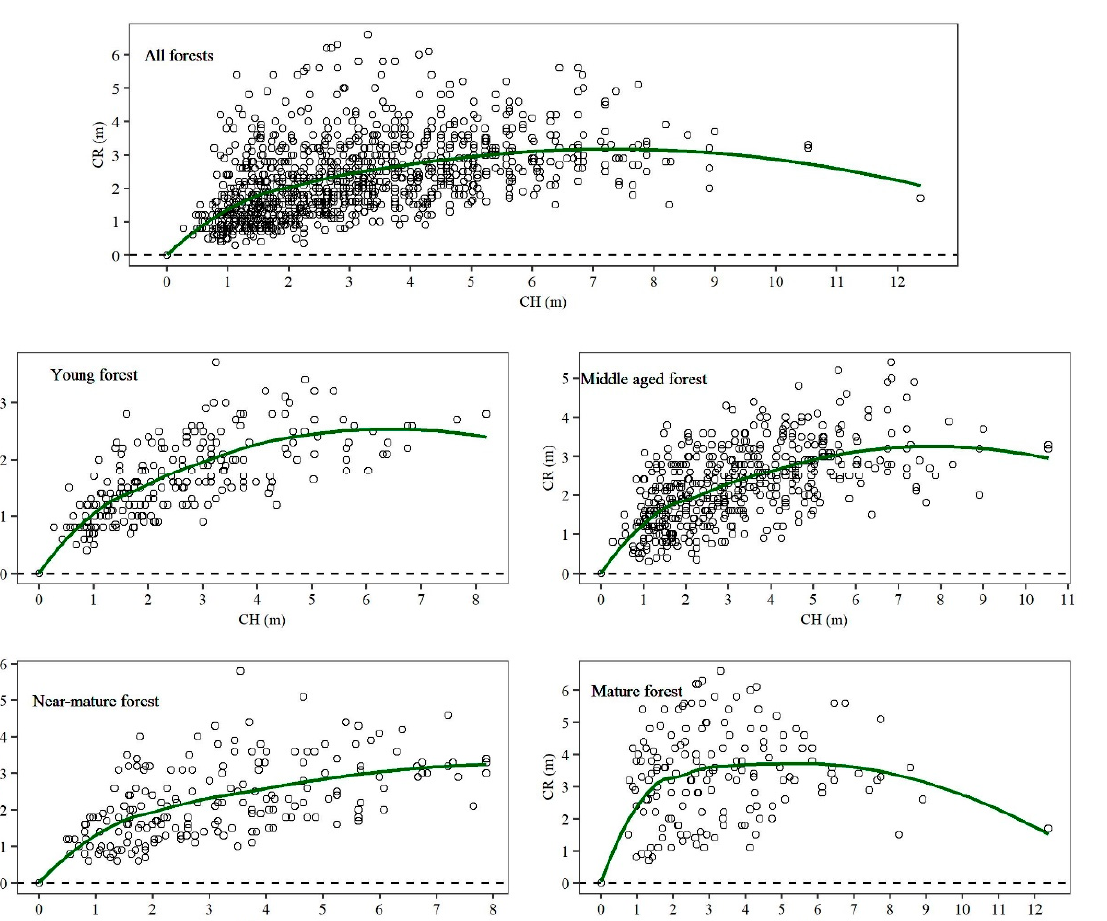
Table 1. Summary statistics of tree characteristic data for 340 sample trees.